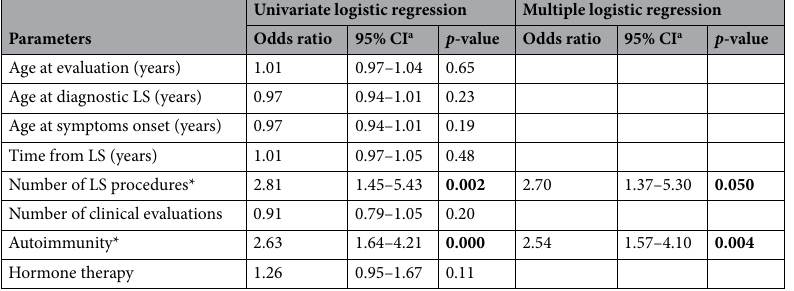
Table 3. Logistic regression analysis of independent risk factors for stage IV of endometriosis disease. LS, laparoscopic surgery. *Variables included in the multiple logistic regression analysis. Bold values denote statistical significance at the p ≤ 0.05 level. a 95% confidence